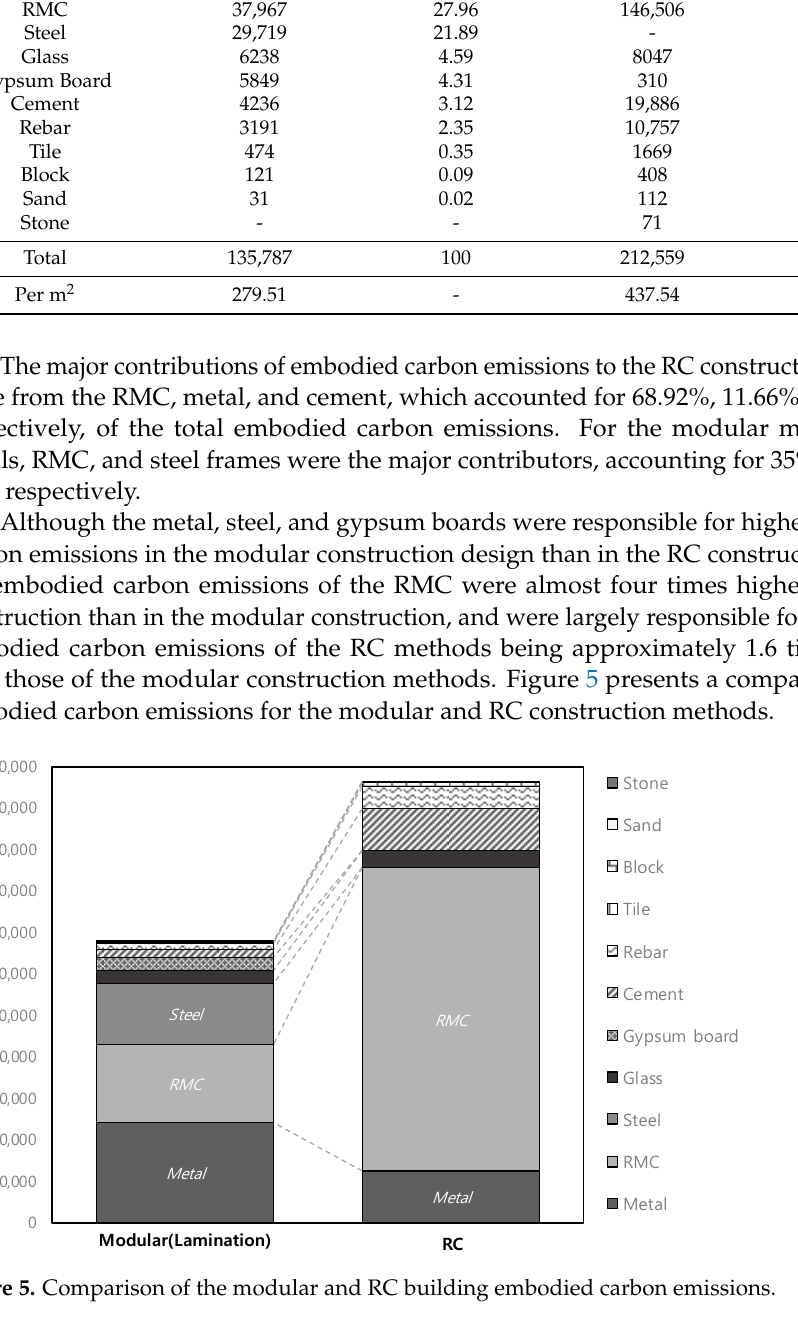
Table 5. Results of the assessment of the embodied carbon emissions.